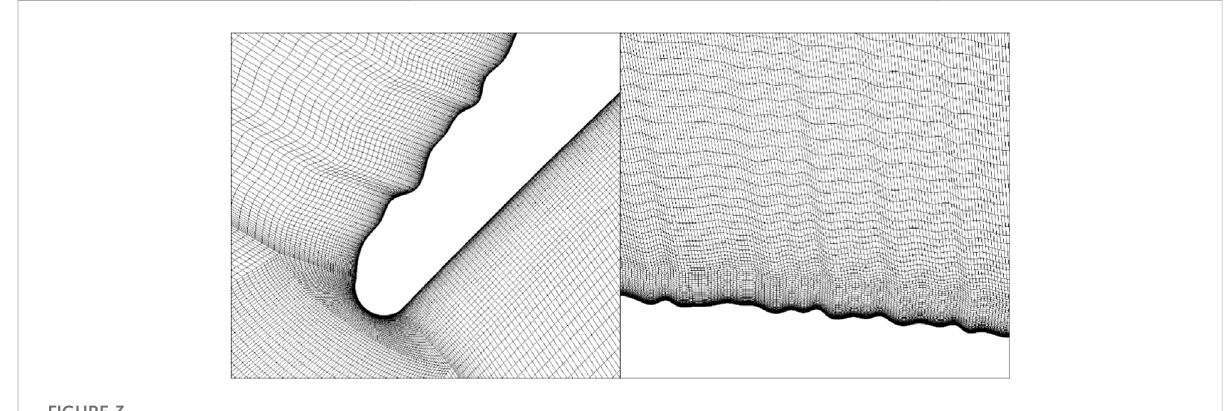
FIGURE 3 Cascade Blade surface Mesh.